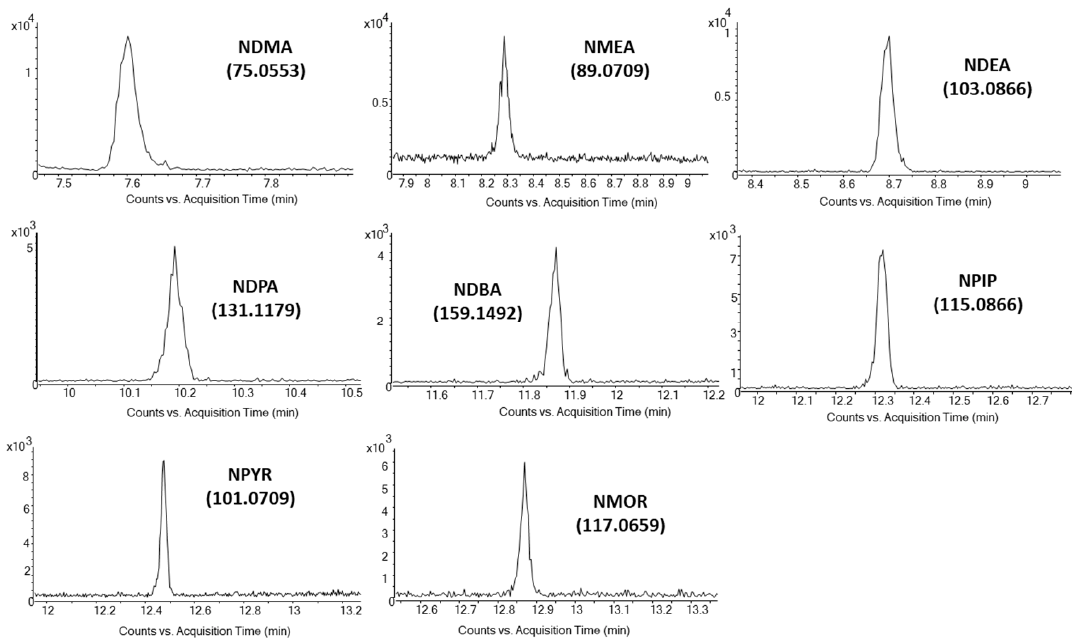
Figure 2. Extracted ion chromatograms ( ± 50 ppm) for an e ffl uent water sample spiked at 10 ng L − 1 .